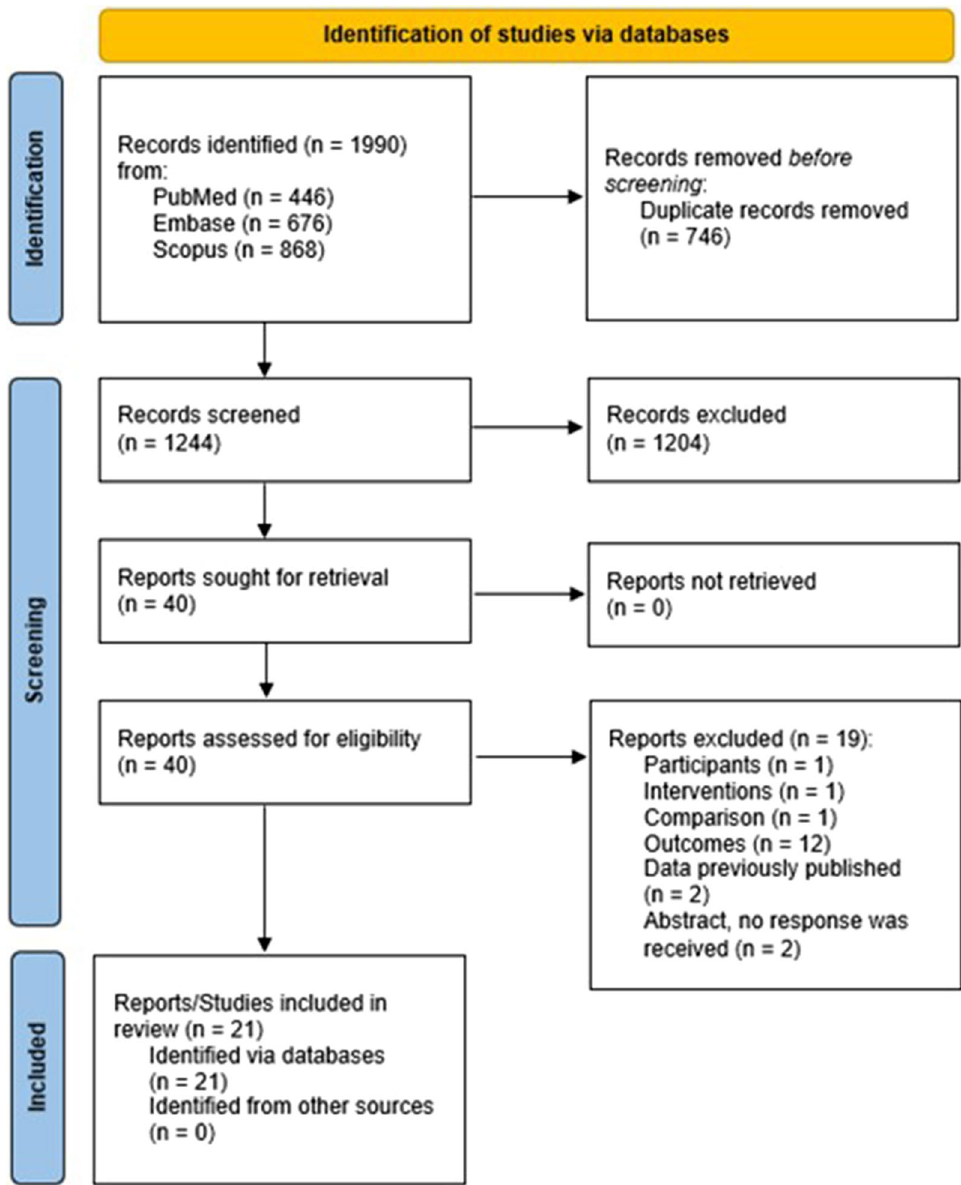
Fig. 1 Flow chart of the study selection